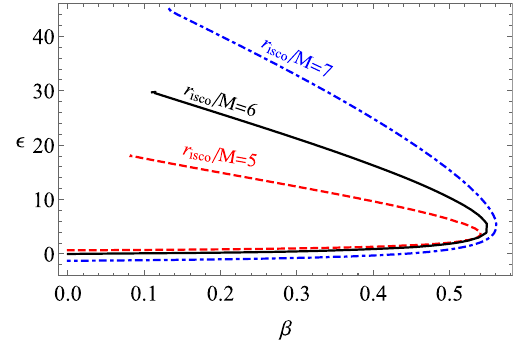
Fig. 11 Relations between the deviation parameter (cid:2) and magnetic couplingparameter β forfixedvaluesoftheISCOradiusofthemagnetic